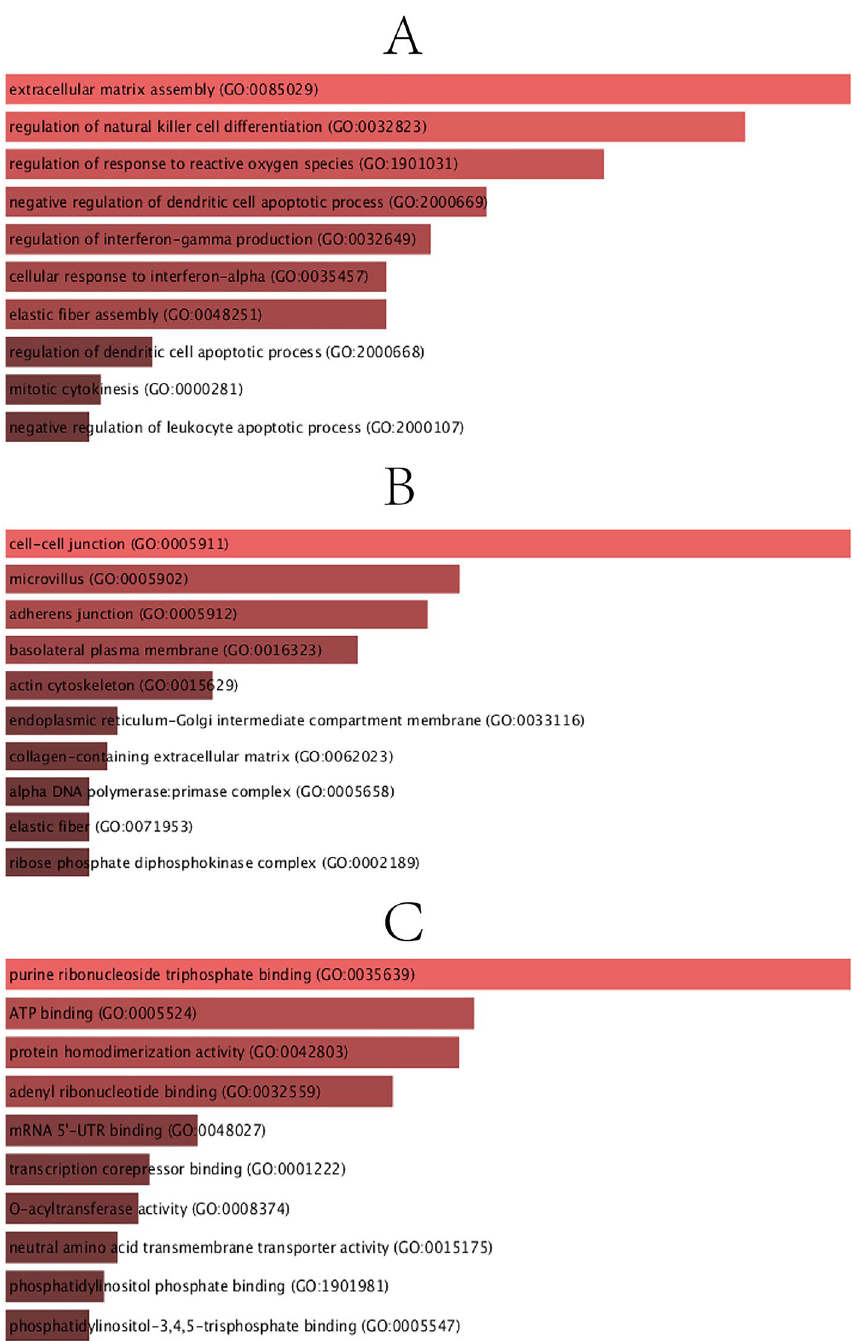
Figure 2. The bar graphs of ontological analysis of shared DEGs among IPF, COVID-19, SCLC, NSCLC, and CRC lung metastases performed by the Enrichr online tool: here, ( A ) Biological Processes, ( B ) Cellular Component, and ( C ) Molecular